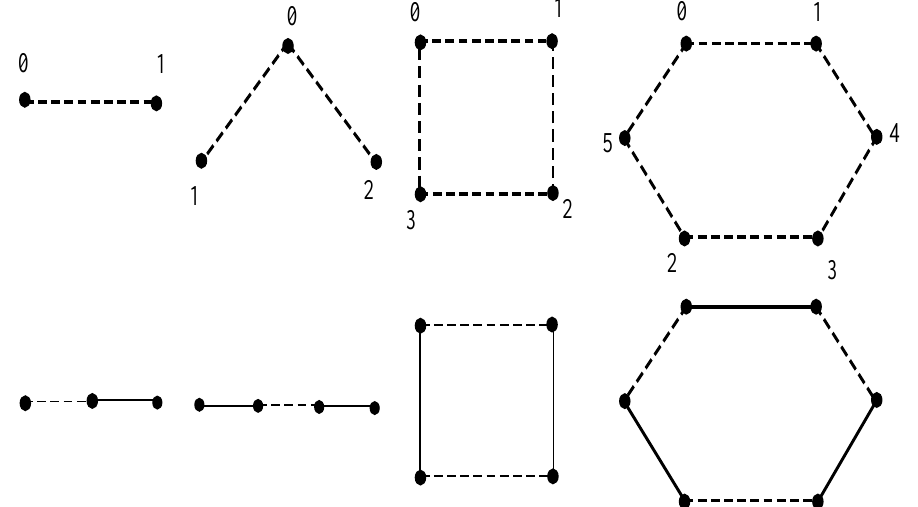
Figure 8. Showing Σ ∧